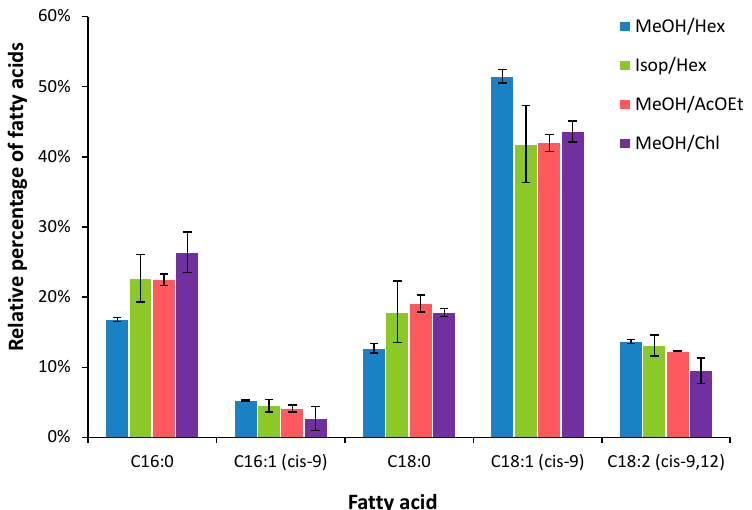
Figure 7. Fatty acid composition in relation to different organic solvents. Each color designates a specific organic mixture. Error bars indicate standard deviation. Number of replicates N = 3.